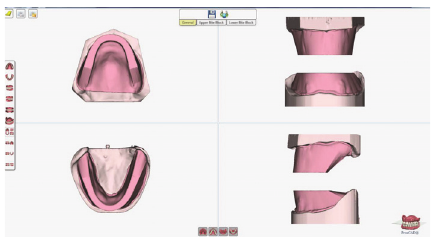
Figure 4: Digital design of the occlusal